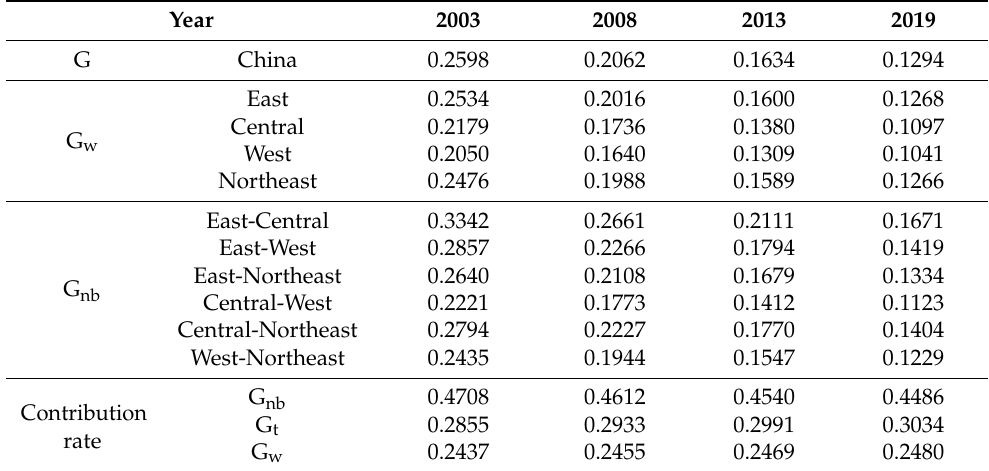
Table 2. Gini coefficient and contribution rate of cultivated land use efficiency in